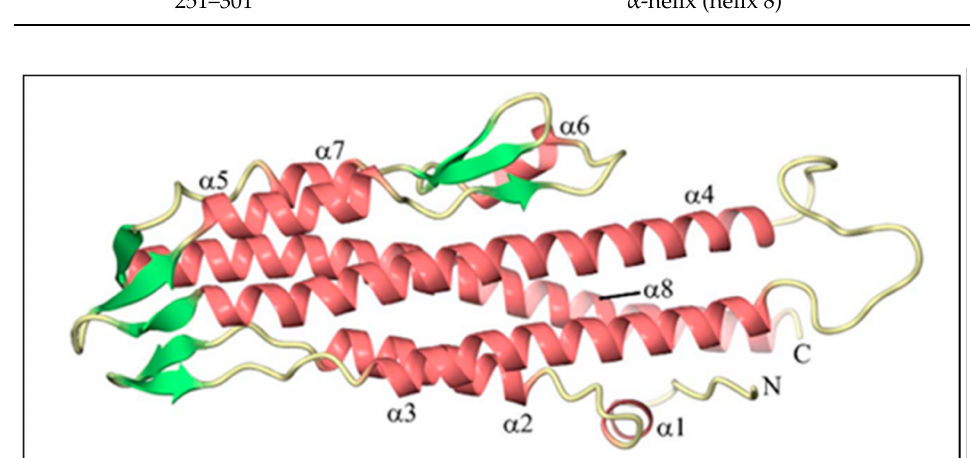
Figure 2. The tertiary structure of Burkholderia invasion protein (BipD) generated using CueMol at 2.1 Å resolution. The pink color indicates helices, whereas the green color represents strands. Adapted with permission from [44]. Copyright © 2006 Elsevier